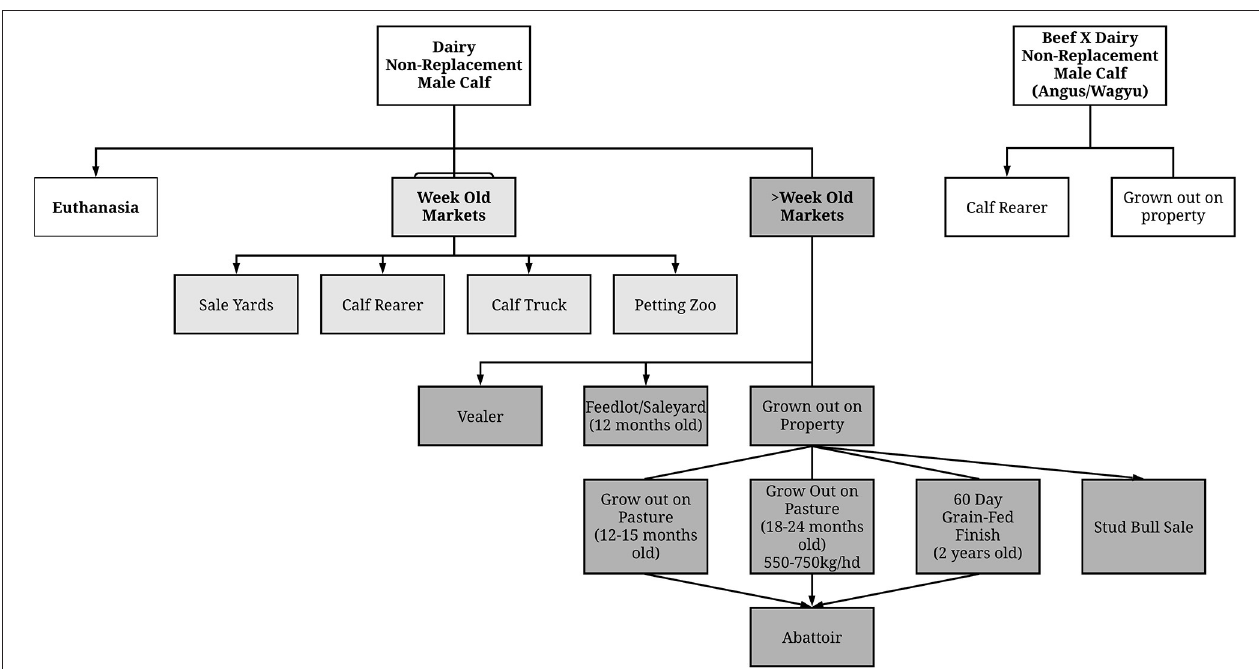
FIGURE 2 | Supply chain access for non-replacement male calves. Arrow ( → ) in diagram denotes end point and/or point of sale from the property of origin.